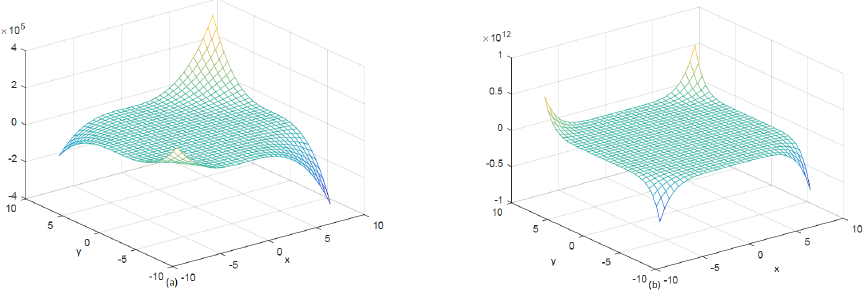
Figure 5: Plotting of (a) M-polynomial and (b) NM-polynomial of